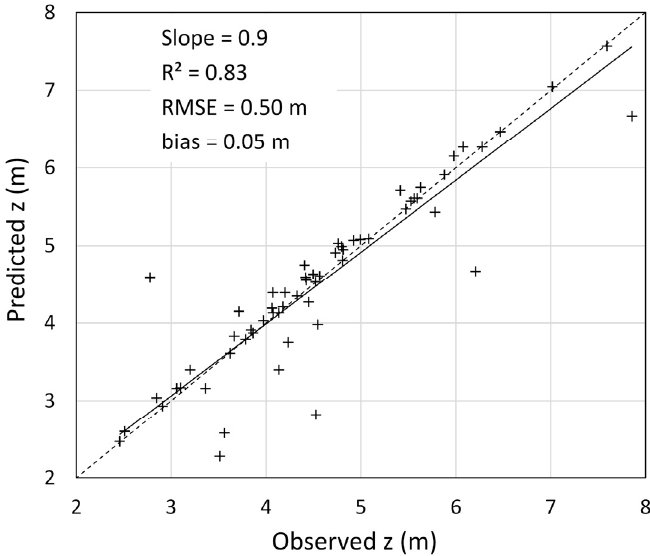
Figure 10. Linear regression between observed heights and predicted heights obtained from the CHM for the sample of trees selected in the verification step.